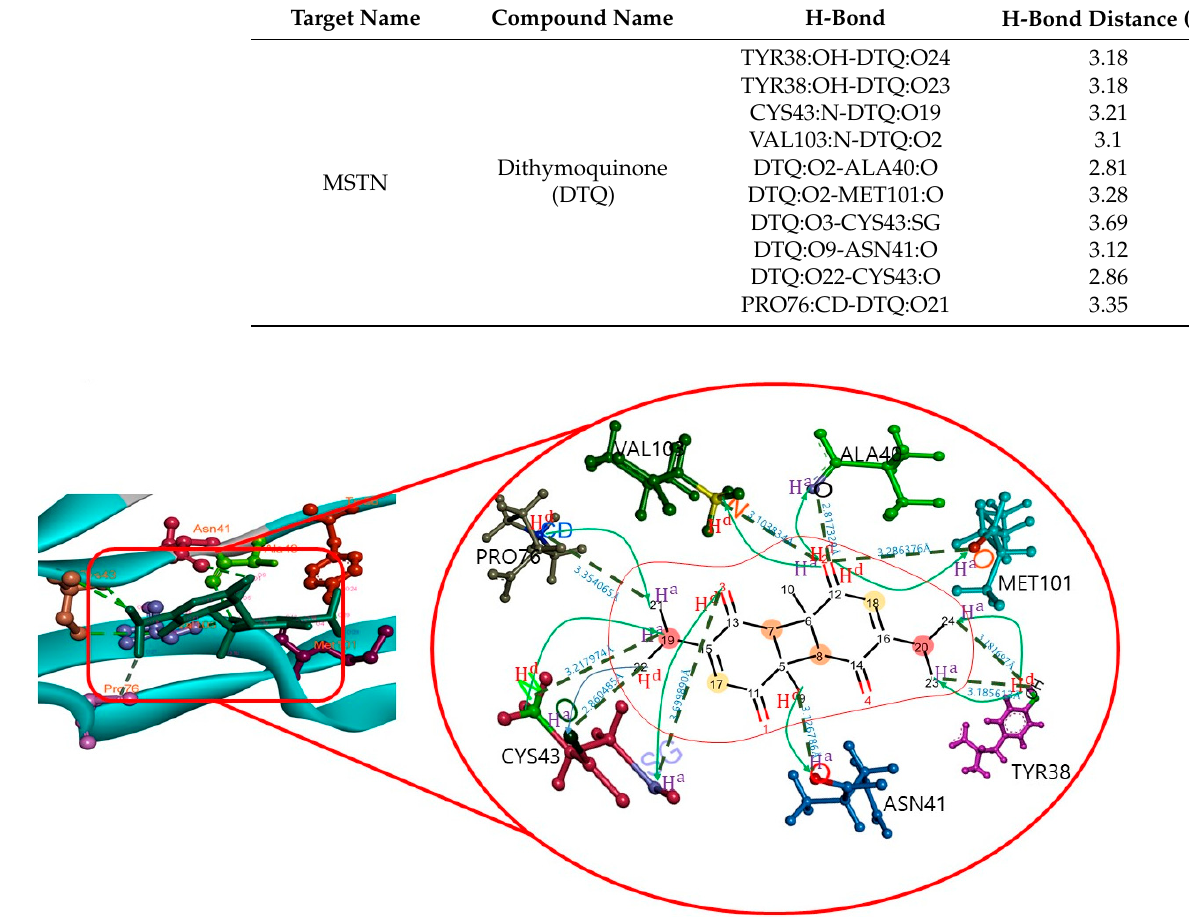
Table 4. List of number of H-bonds present in the DTQ–MSTN complex.